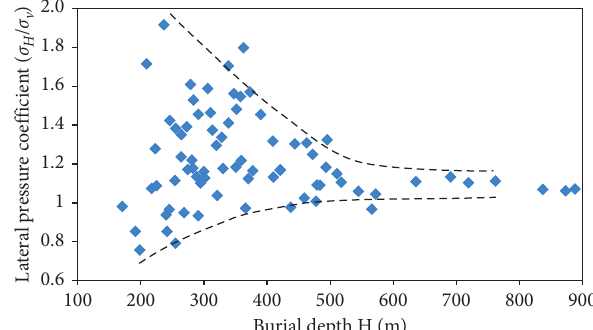
σ h = 0.0182H + 1.0429 R 2 = 0.7951 Figure 5: Relationship between the lateral pressure coefficient (LPC, σ H/ σ v ) and the burial depth.